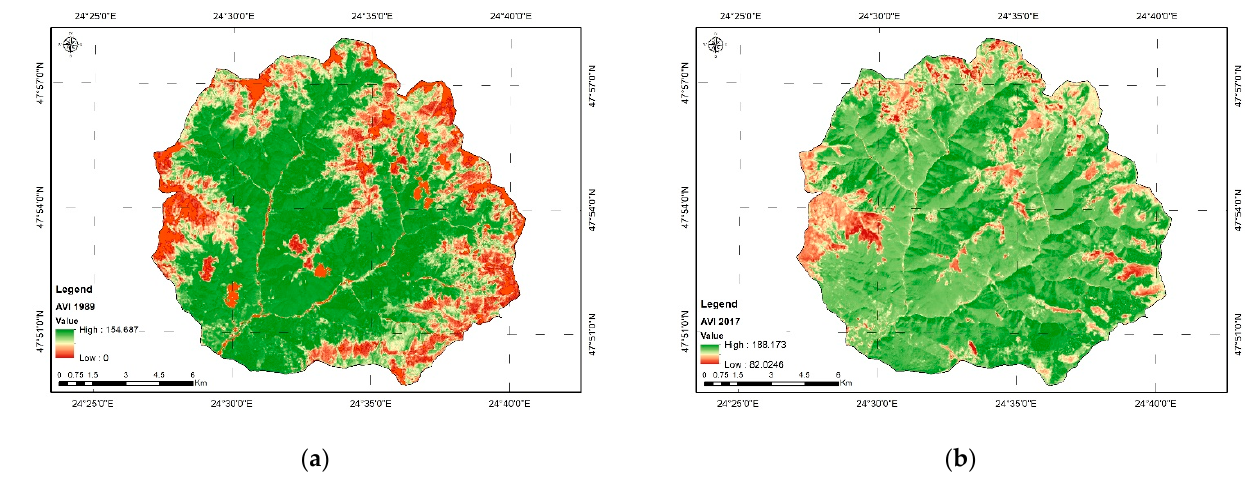
Figure 4. Advanced vegetation index (AVI). ( a ) AVI 1989, ( b ) AVI 2017.